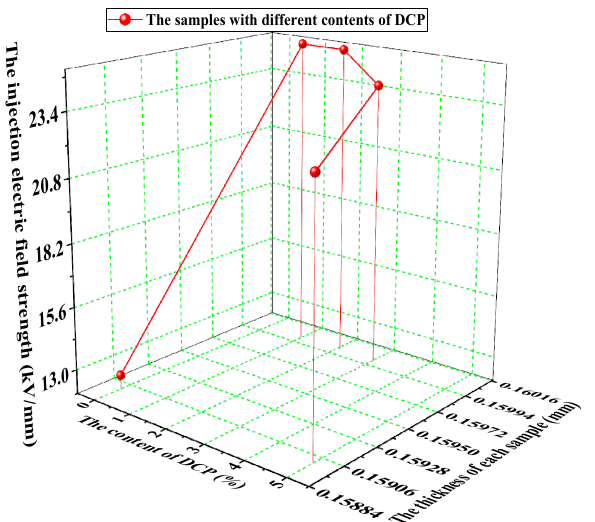
Figure 3. The threshold field strength of samples with different contents of DCP (Red dots represent the samples with different contents of DCP).